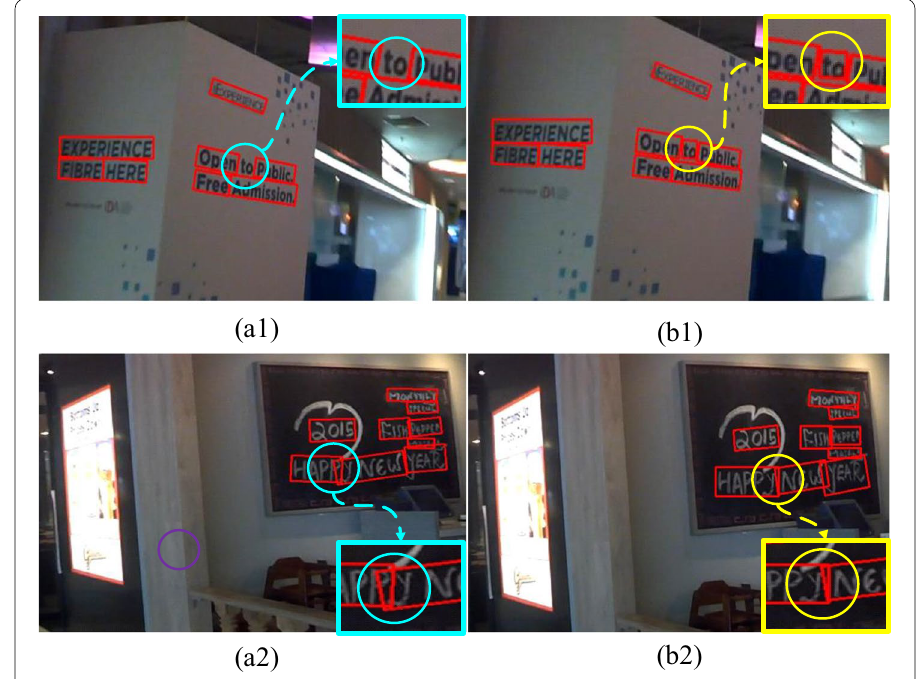
Fig. 6 Examples of test results: ( a1 and a2 ) are the missed detection and false detection results of the original PSENet, respectively; ( b1 and b2 ) are the results of the proposed